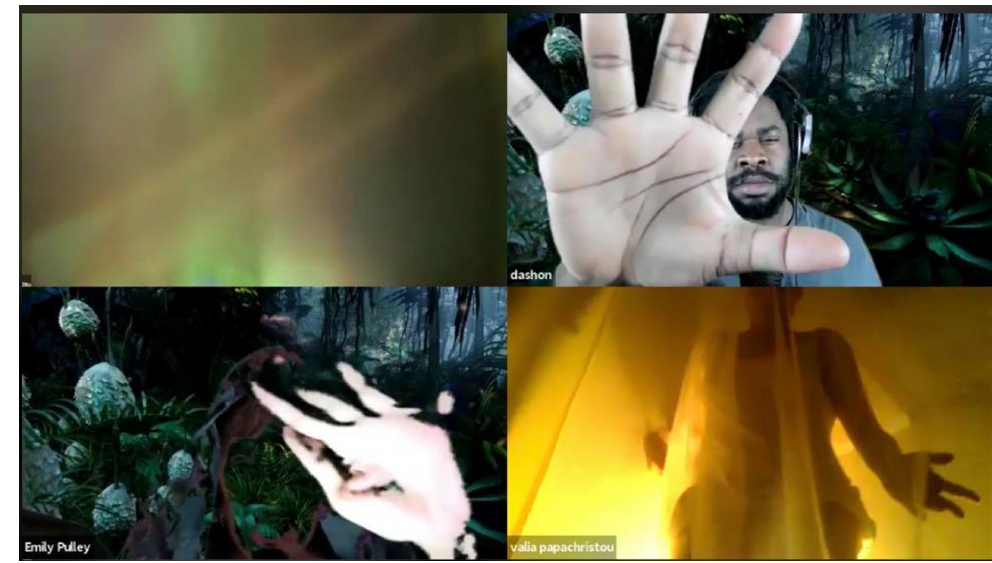
Figure 13. Noor Inayat Khan, directed by Elli Papakonstantinou, Ulys, Telemachus and Penelope, in Aède of the Ocean and Land: A Play in Seven Acts . 2020. Screenshot from the Zoom Live Music-Cinema Event. © The Inayatiyya.